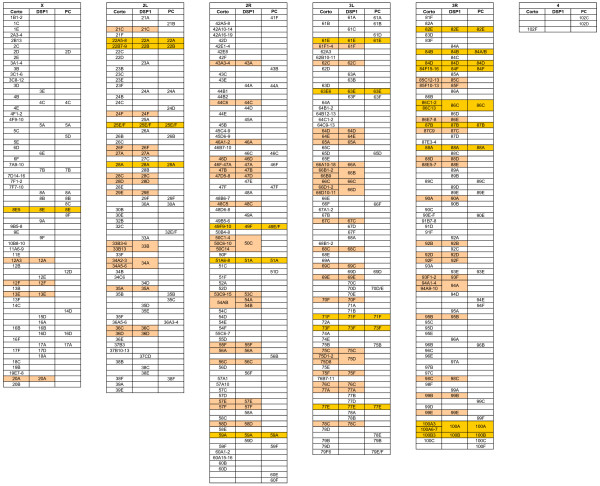
Comparison of Corto, DSP1 and PC localizations on polytene chromosomes of Oregon-R wild-type strain.